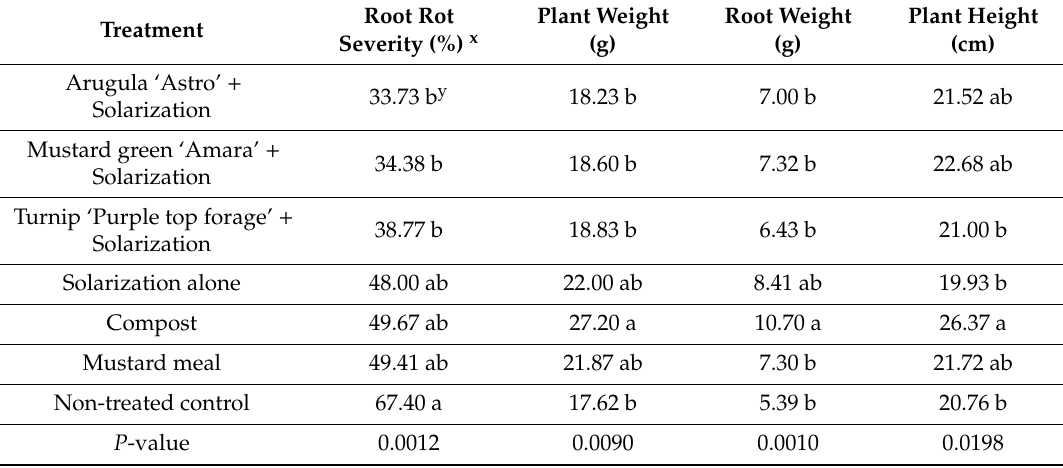
Table 1. Mean Rhizoctonia root rot severity and plant growth data of flowering cherry plants treated with solarization alone or in combination with cover crops, compost, and mustard meal, 2016 on-farm